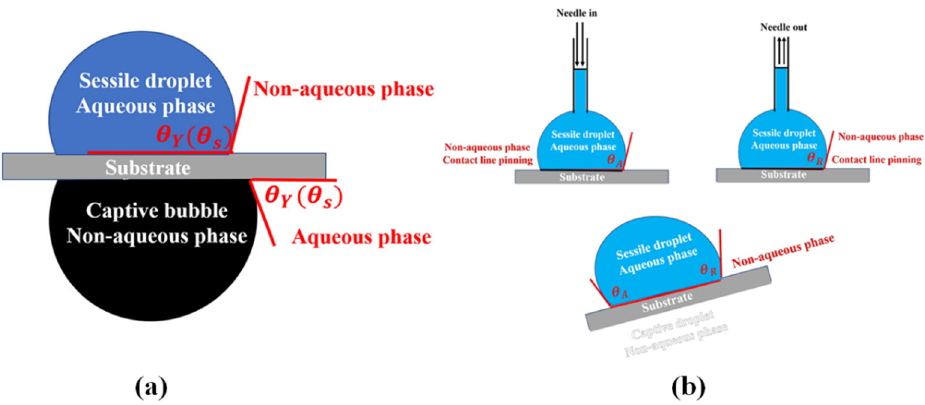
Figure 1. ( a ) Schematic diagram of methods for sessile drop and bubble capture; ( b ) Schematic diagram of dynamic contact angle measurement. (modified from [17]).